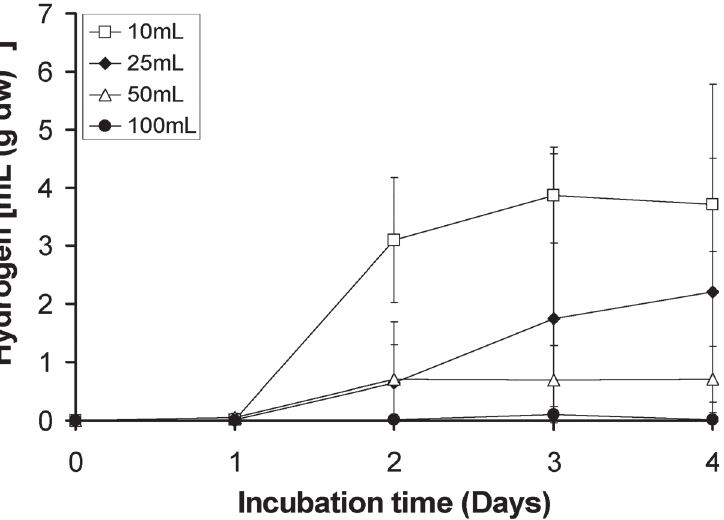
Fig 3. Kinetic of hydrogen production of the lichen Pleurosticta acetabulum in several initial volumes of culture